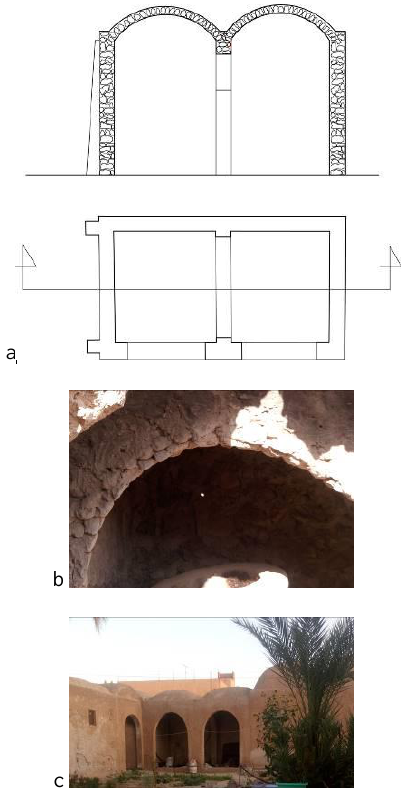
Figure 9. a. Plan-section of double domed units. b. Radial texture of the connection arch. c. Gallery with arcades.